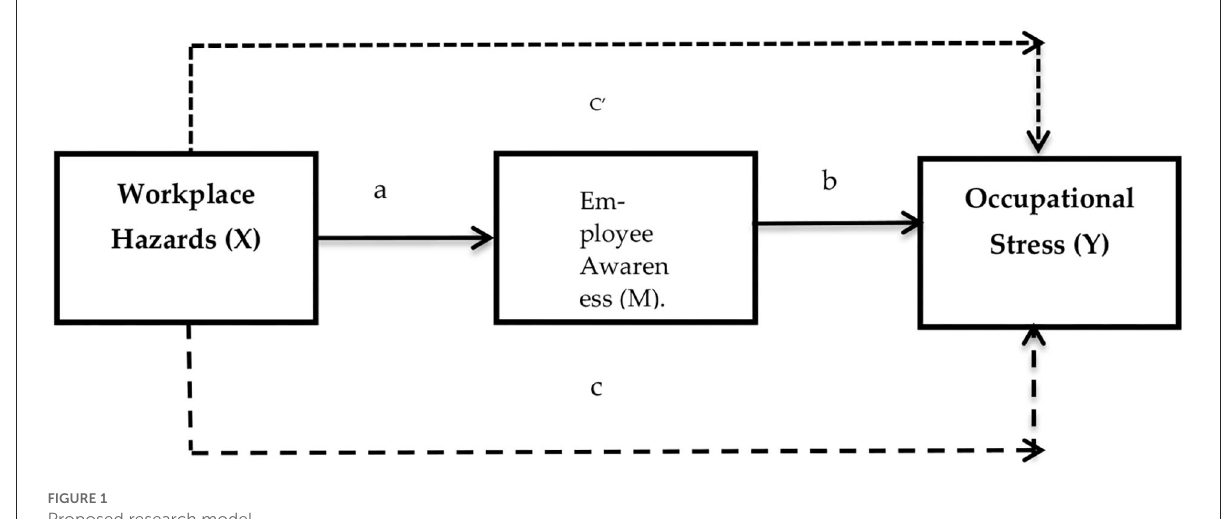
FIGURE1 Proposed research